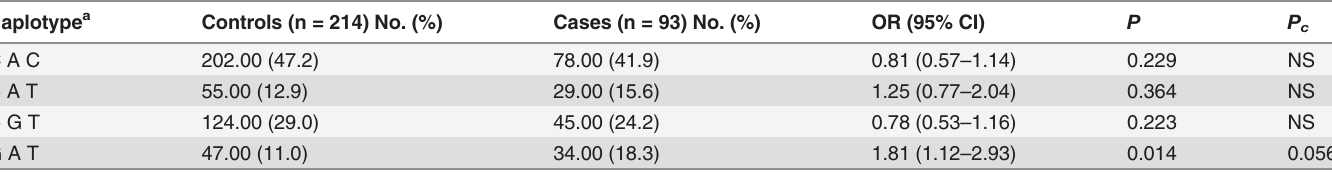
Table 5. Association between haplotypes of the three tagSNPs in SIRT1 gene with the risk of MI among younger subjects ( (cid:1) 55 years old). Haplotype a Controls (n = 214) No.